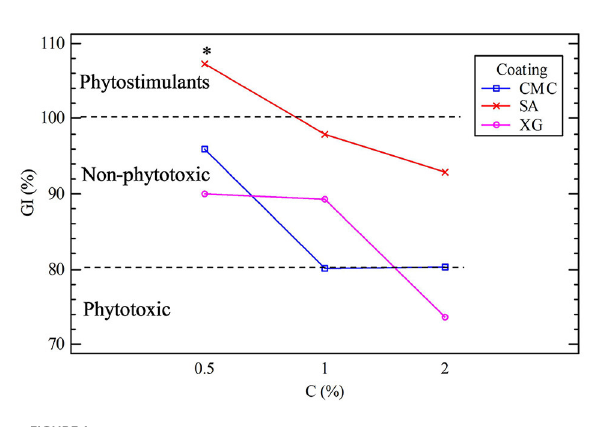
FIGURE1 Interaction plot of Germination Index(%) to relate the substances tested (sodium alginate-SA; carboxymethyl cellulose- CMC; and xanthan gum-XG) at different concentrations (C%) (0.5, 1, and 2%) as liquid coatings for cucumber seed priming. Asterisks show different homogeneous groups with statistically significant differences (Fisher’s LSD test, P <